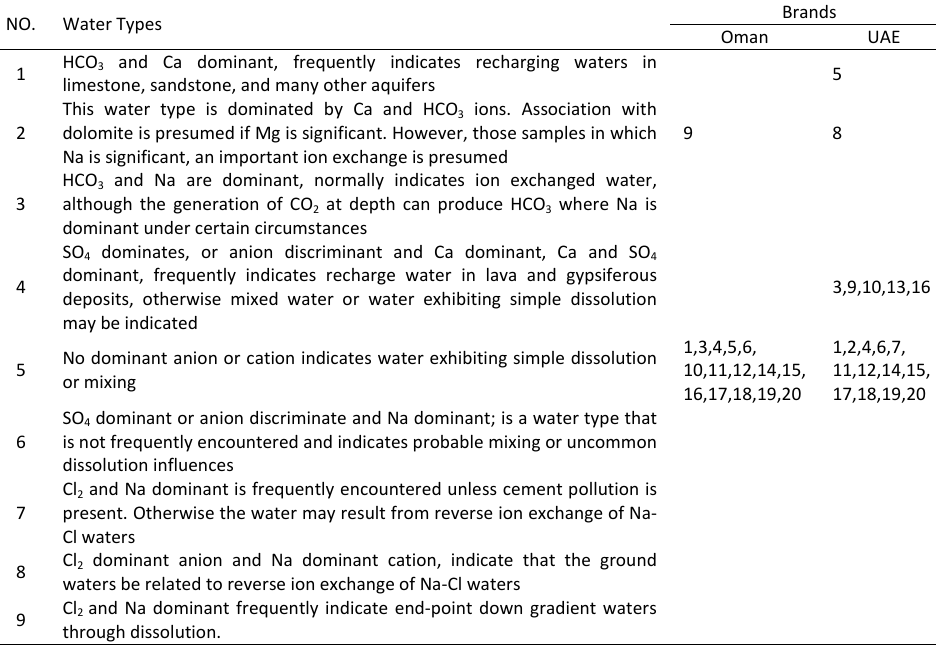
Table 4: Classification of Omani and UAE bottled water brands based on Durov diagram